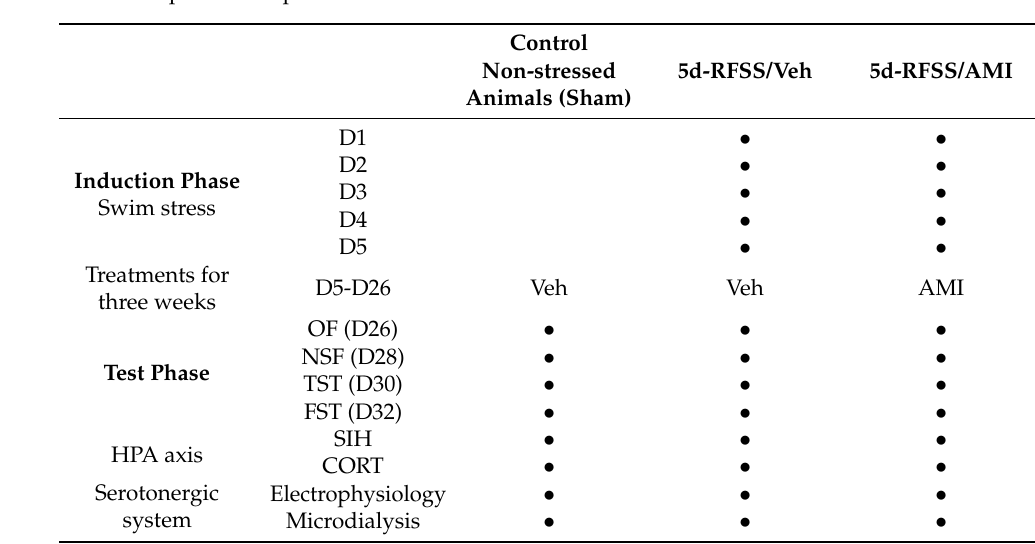
Table 1. Experimental protocol of